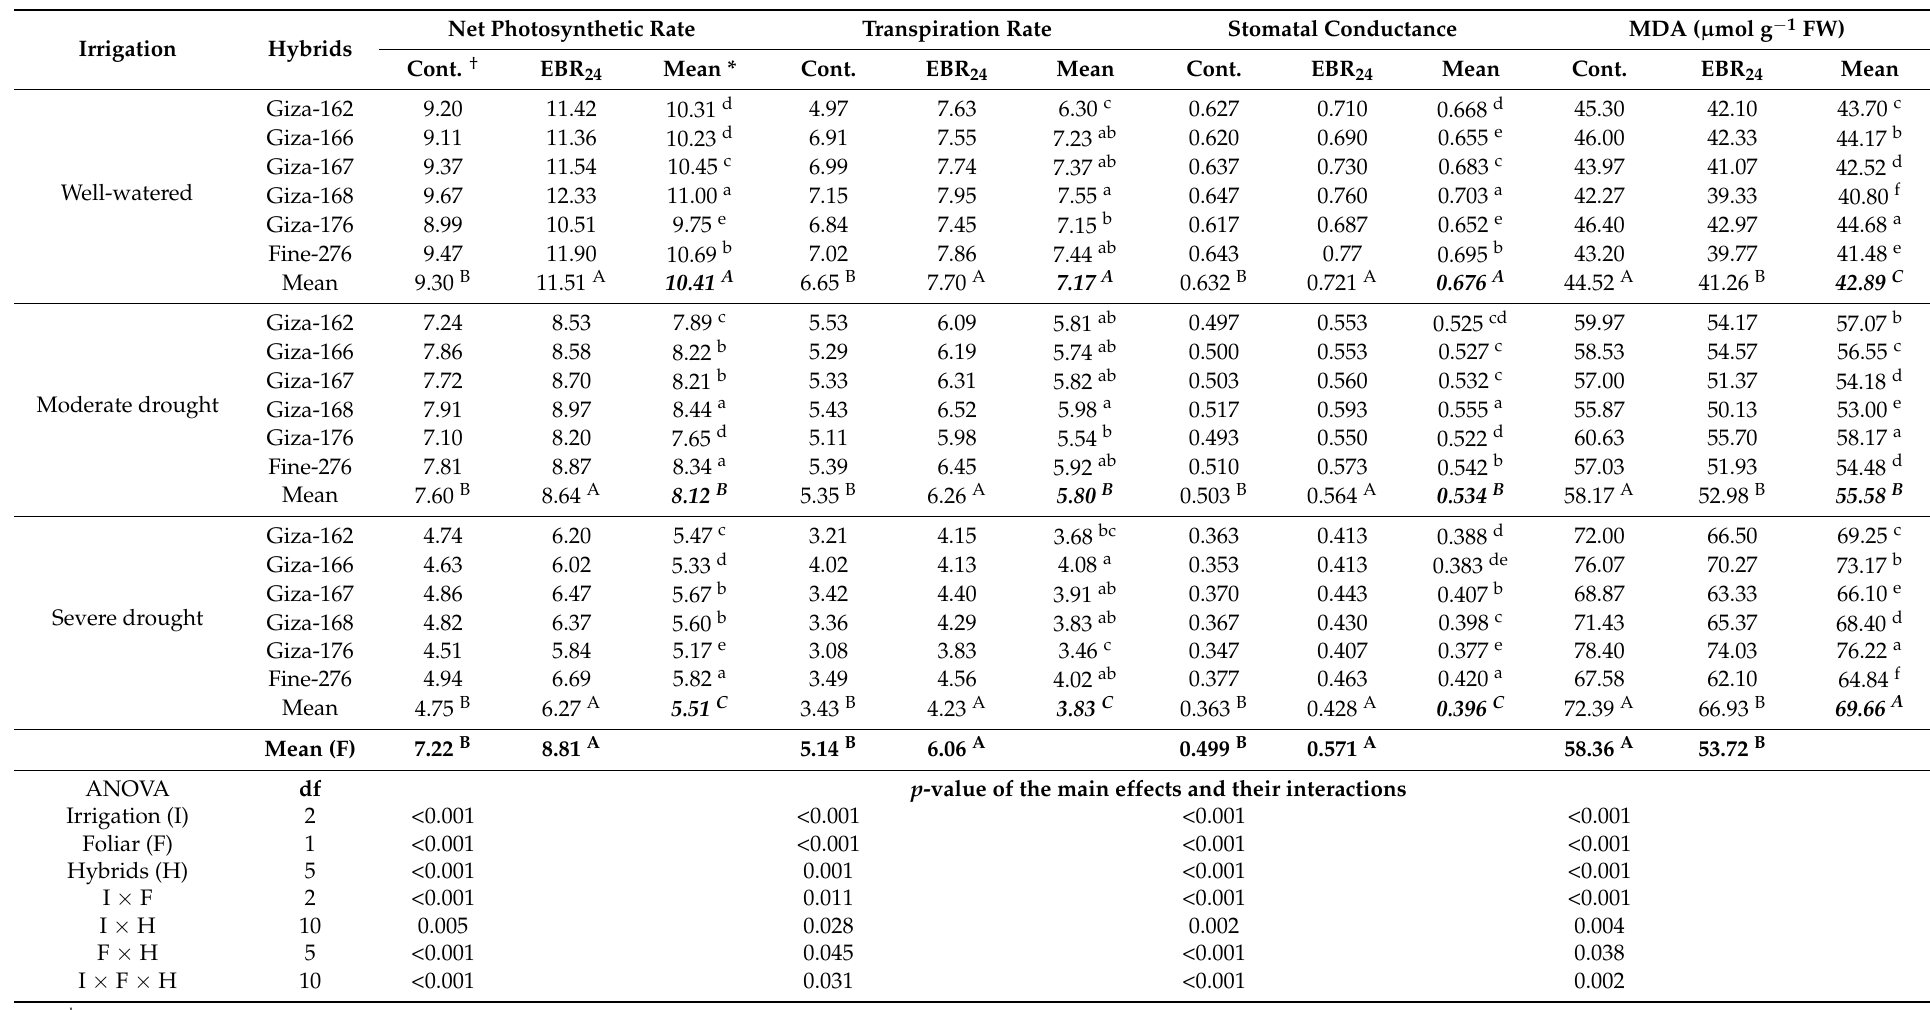
Table 3. Impact of 24-epibrassinolide (EBR 24 ) application on the net photosynthetic rate, transpiration rate, stomatal conductance, and malondialdehyde (MDA) of six maize hybrids grown under three irrigation regimes over the two growing seasons of 2018 and 2019. Irrigation